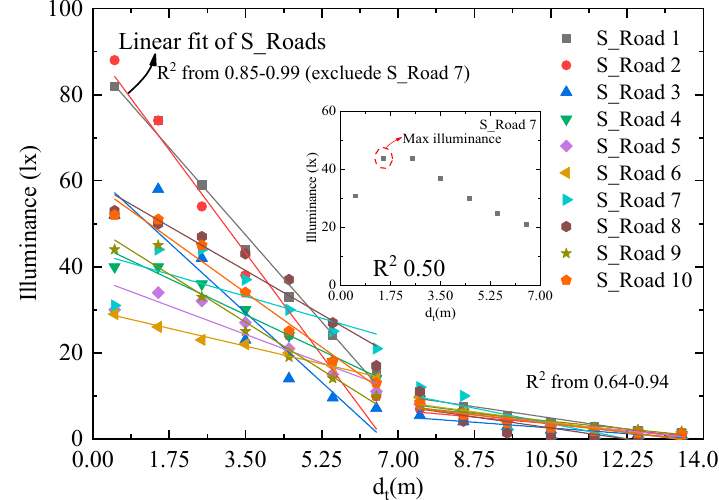
Figure 8. Illuminance distributions in the transverse direction fitted with linear function.